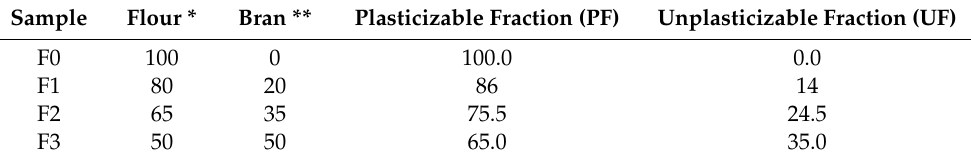
Table 1. Content of plasticizable fraction (PF) and fiber in% wt. of the